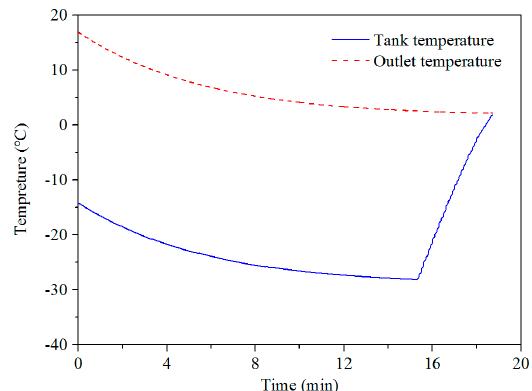
Figure 10. Changes in the pressures in the tank and at the outlet of the leak hole over the leakage duration time.